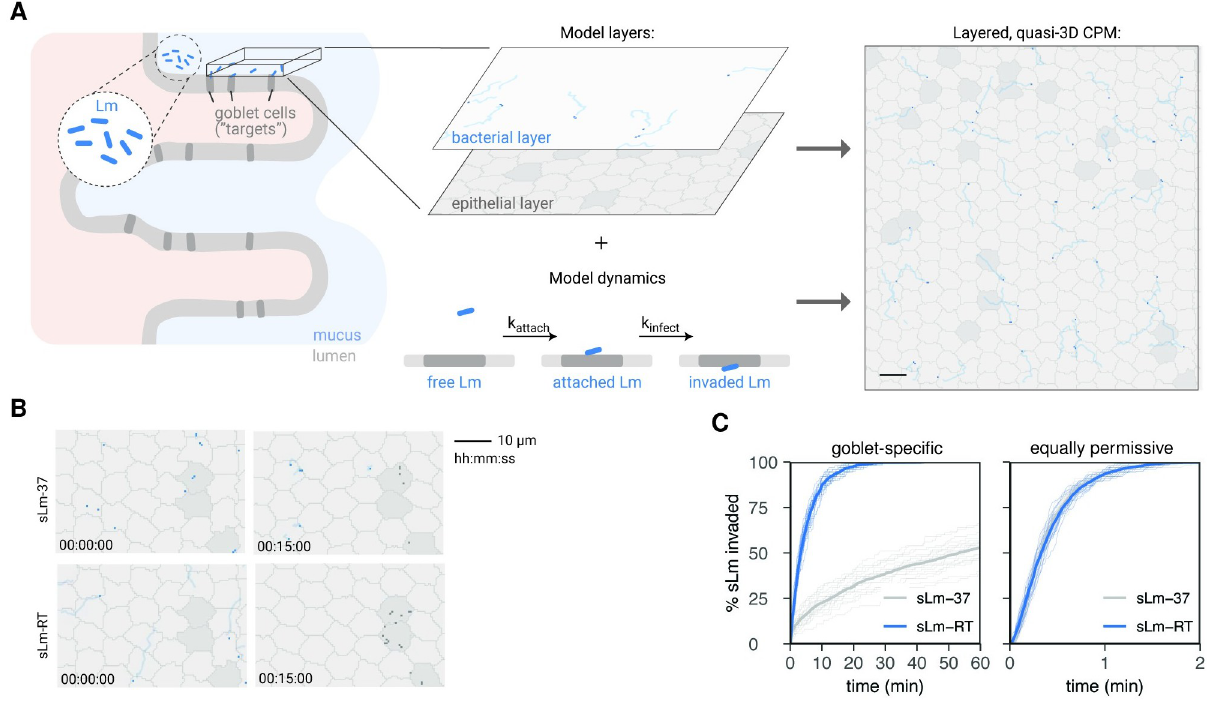
Fig 4. Bacterial motility enhances target cell invasion in a cellular Potts model (CPM) of the epithelium. A: The CPM describes the surface of the small intestinal epithelium (left). The model consists of two layers: the gut epithelium (including target cells in dark gray) and a layer above where bacteria (simulated Lm, sLm) move. Bacteria (blue dots) are shown with their traces (light blue). A bacterium that finds itself above a target cell in the epithelial layer can attach to it (rate k attach ), and subsequently invade (rate k infect ); both are irreversible processes. These layers together with the invasion dynamics yield the full, quasi-3D model of the gut epithelium (right; scale bar = 10 μ m). See Methods for details. B: Example screenshots of non-motile (sLm-37) and motile bacteria (sLm-RT) at the start of the simulation and after 15 min. C: % sLm invading over time, showing 20 individual simulations (thin lines) and average invasion (thick lines) for both non-motile (gray, sLm-37) and motile bacteria (blue, sLm-RT). Left: “goblet-specific” invasion where sLm can only invade goblet “target” cells, right: invasion when all epithelial cells are target cells (equally permissive to